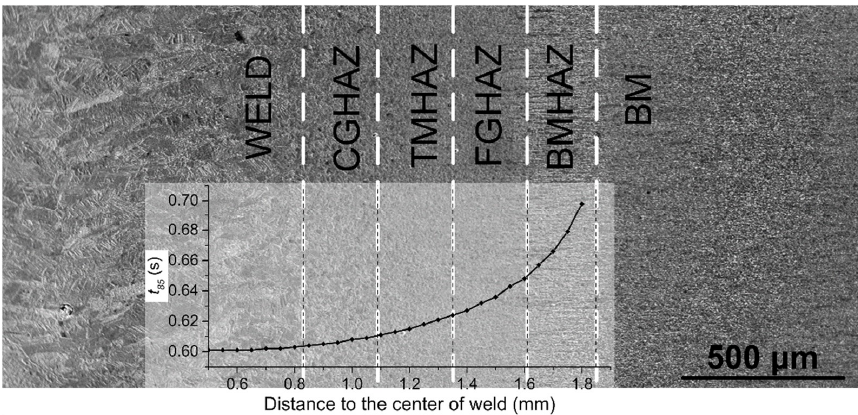
Figure 5. Microstructural zones and the trend of t 8/5 in the X100 laser-welded joint.